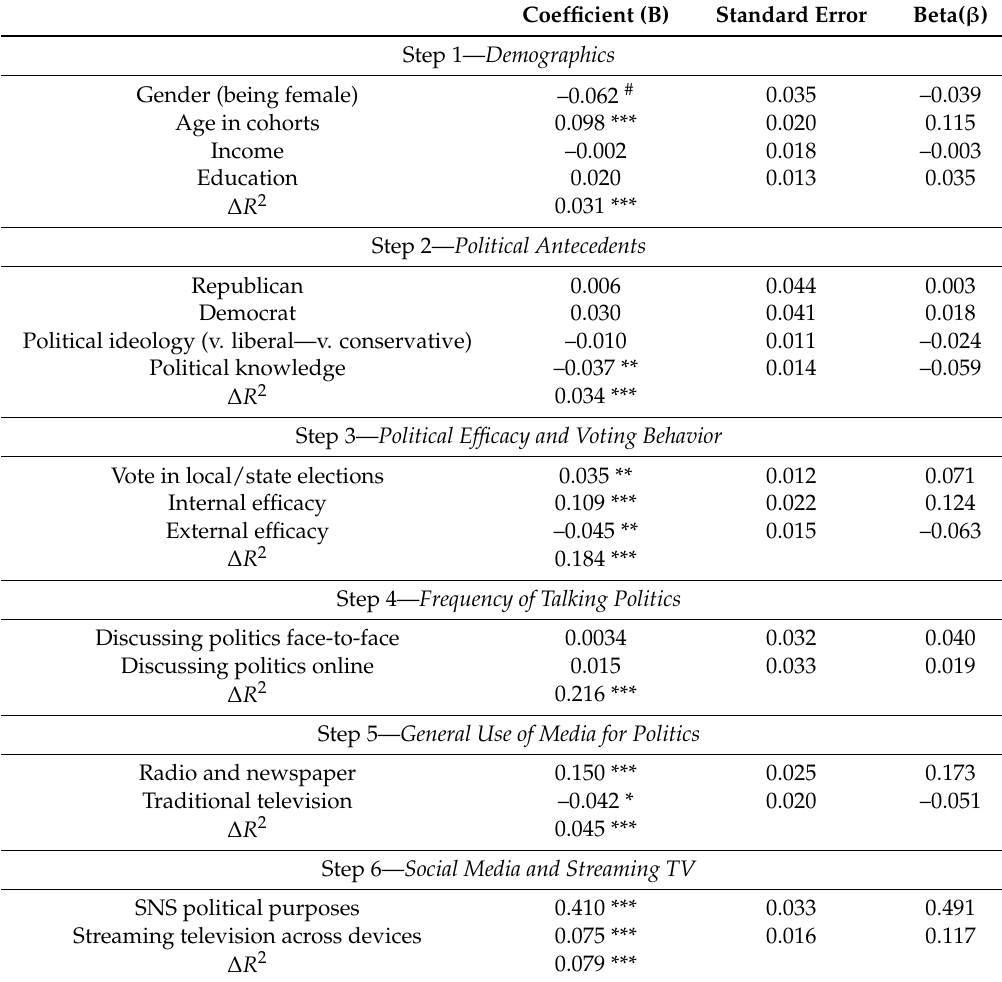
Table 2. Regression Model of Online Political